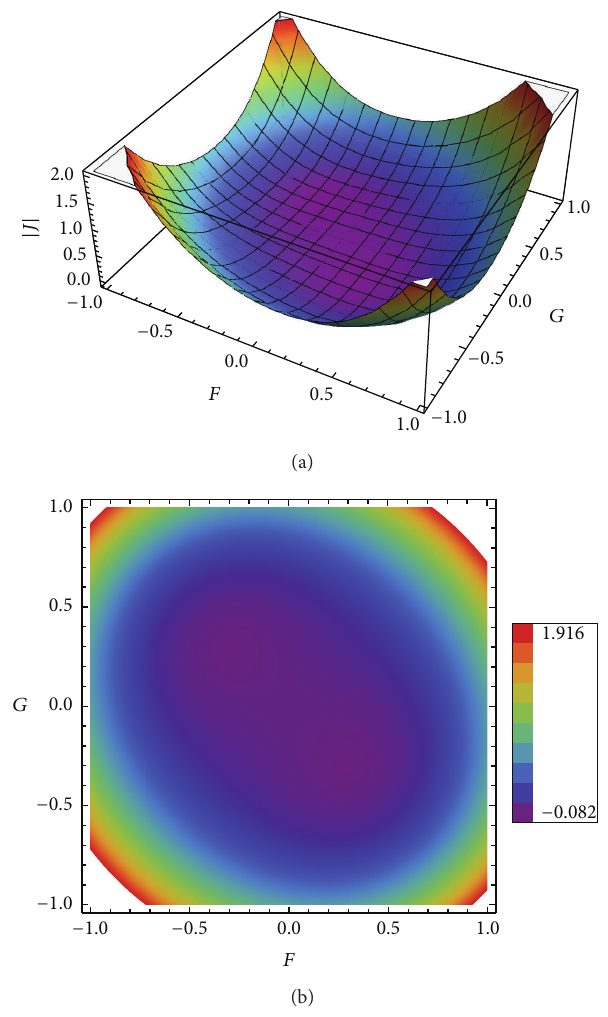
Figure 2: (a) 3D plot and (b) contour plot of det (𝐽 𝑇 ) in the 𝛽 = 1 case which accepts “Thirring